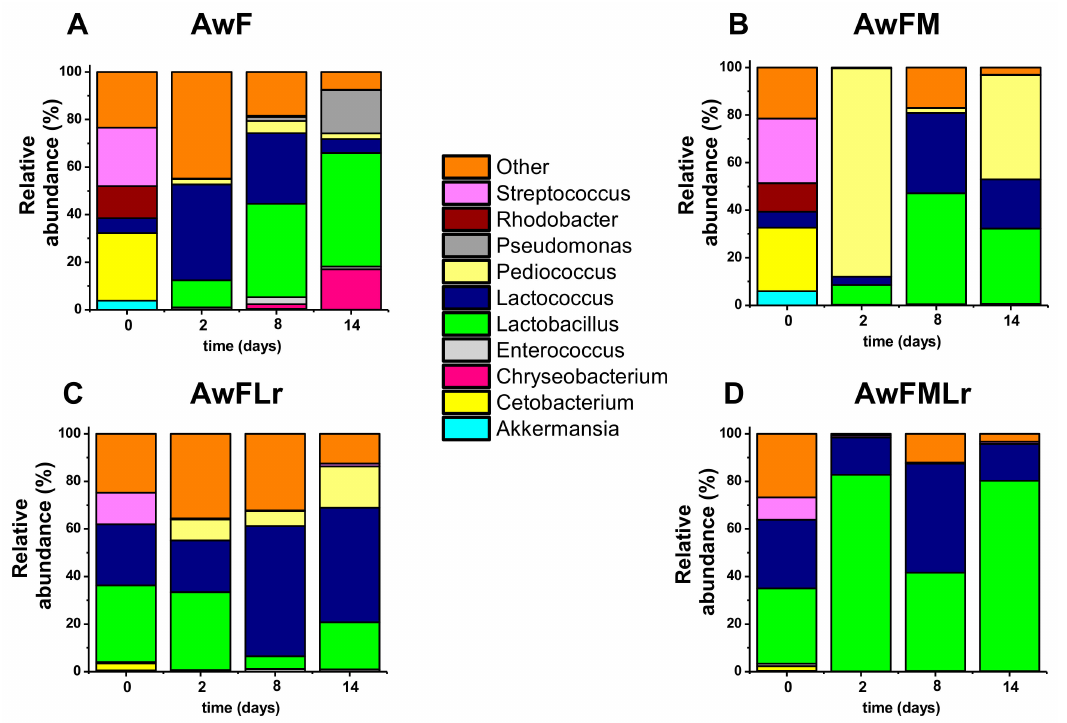
Figure 5. The relative abundance of the microbial community at the genus level of the fermentation. ( A ) AwF; ( B ) AwFM; ( C ) AwFLr; ( D )